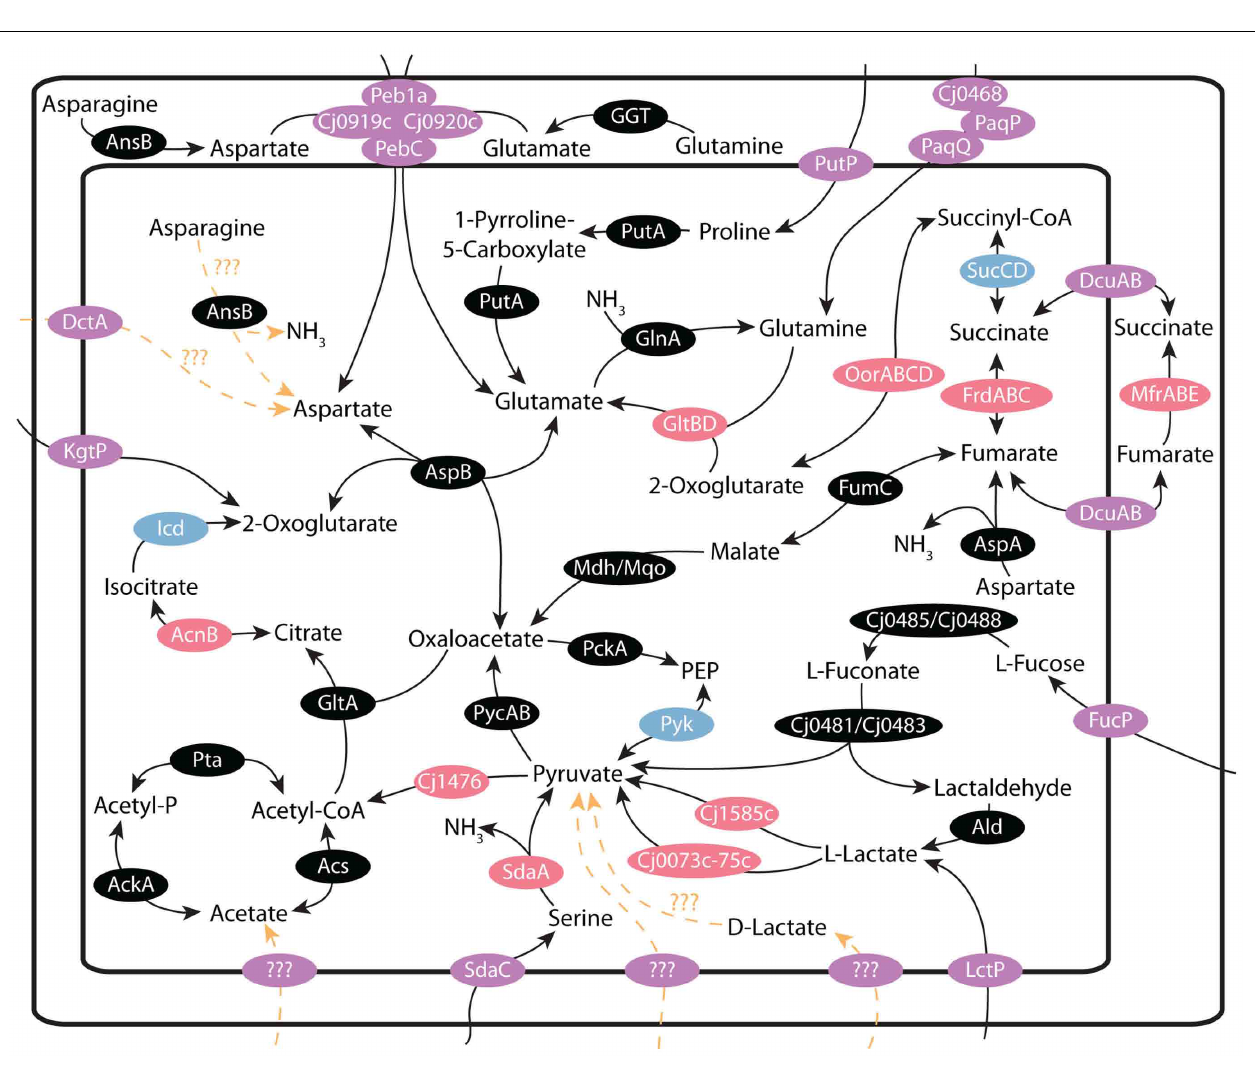
production of pyruvate. Glutamate and aspartate also play key roles in the production of citric acid cycle intermediates. Enzymes or enzyme complexes containing iron–sulfur complexes are indicated in pink, magnesium containing enzymes are indicated in blue, transporters are denoted as purple and hypothetical reactions are indicated in